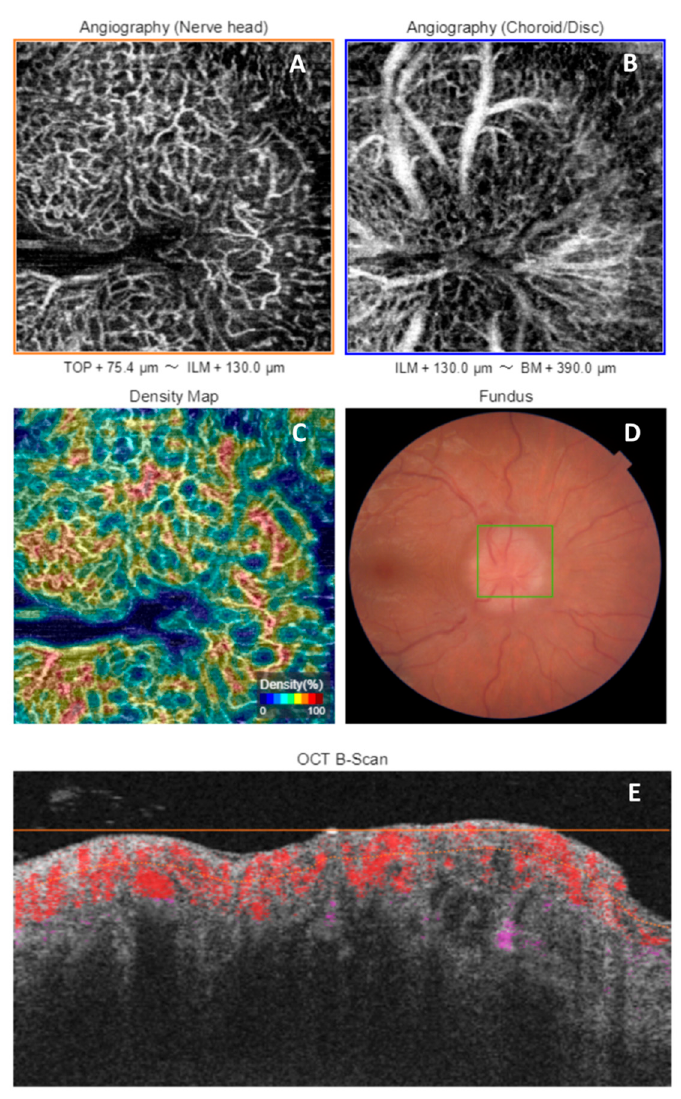
Figure 2. Optic nerve OCT (DRI OCT Triton system, Topcon) corresponding to the right eye of a patient with chronic bilateral papilledema secondary to intracranial hypertension ( A – E ). ( A , B ) Vascular tortuosity in different segmentations and enlargement of the vessels and capillaries can be seen. ( C – E ) The corresponding vessel density map, fundus photograph and B scan are provided in ( C – E ) respectively.